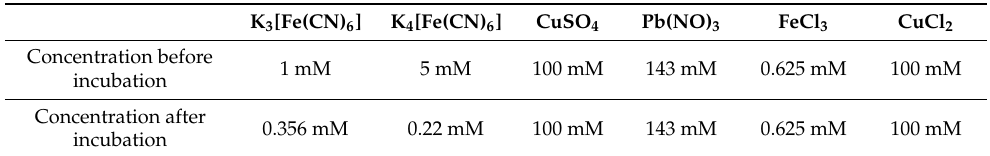
Table 1. Concentration of salts of various metals before and after incubation of the polyelectrolyte complex PSS-PAH in solution.